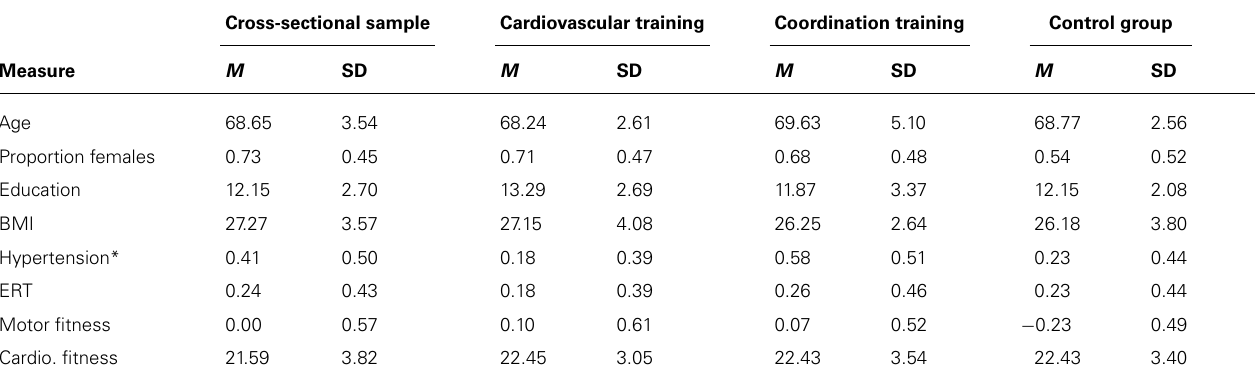
Table 1 | Demographic information [mean (M) and Standard deviation (SD)] for participants of the cross-sectional sample ( N = 75) and of the two experimental groups (cardiovascular training, coordination training) and the control group (stretching and relaxation; N = 49) at measurement time point t